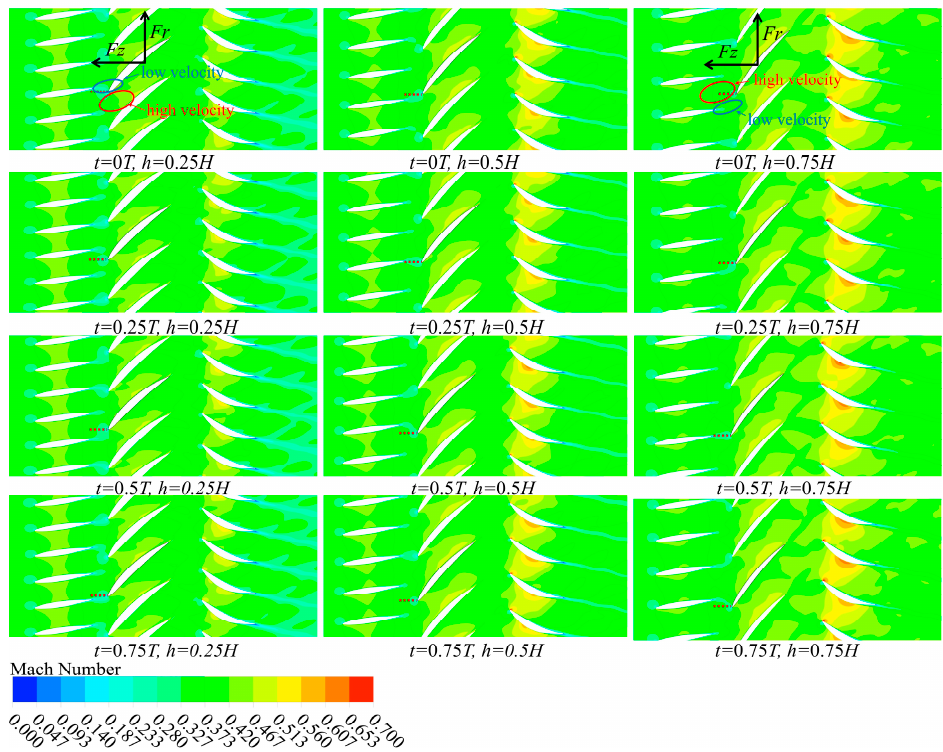
Figure 21. Mach number distribution of the 𝑎 = − 10 mm model under near-blockage conditions.